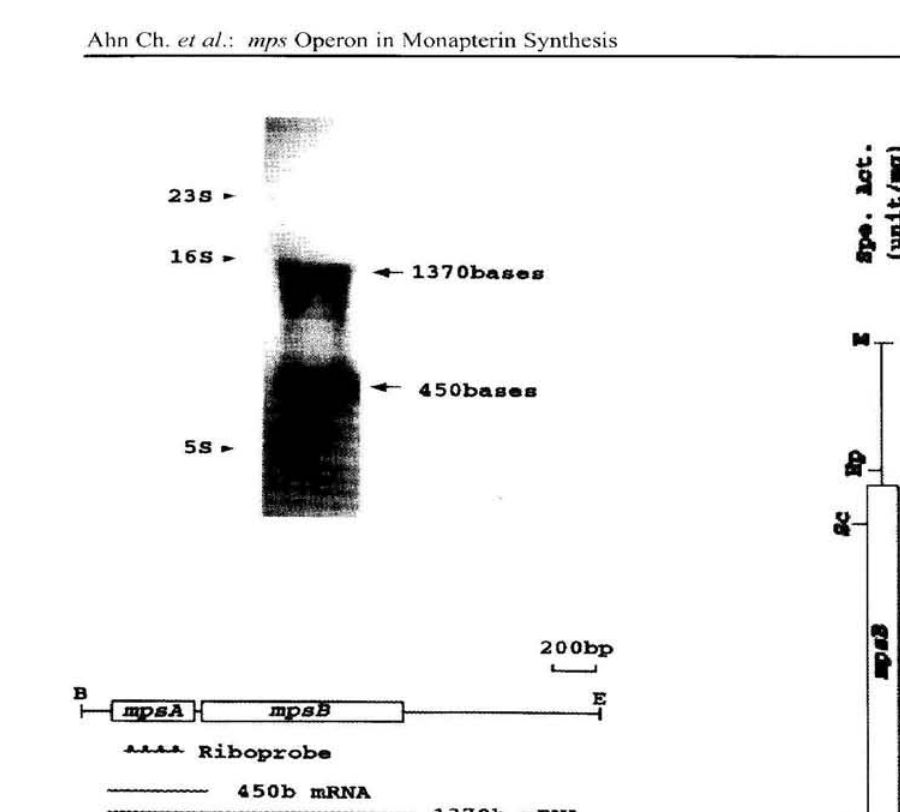
Figure /. Northern blot analysis of the tiiRNA tran- scribed by the mps operon. A '-P-riboprobe comple- mentary to the mpsA coding sequence was used. Two hybridized mRNAs are indicated by arrows.